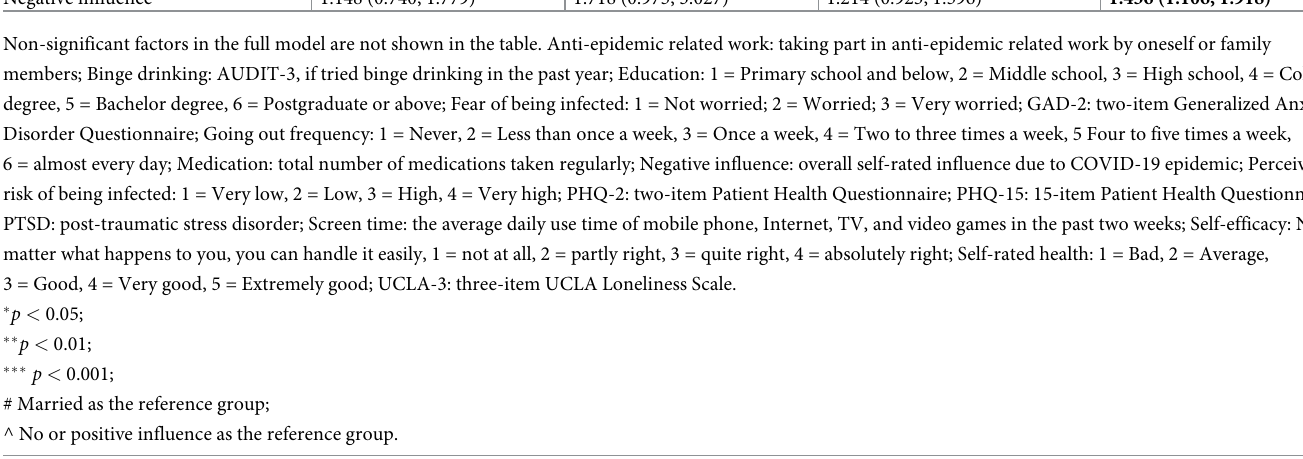
Hubei province, binge drinking, more chronic diseases, more medications taken regularly, higher PHQ-15, lower self-rated health, lower self-efficacy, cases around, higher perceived risk of being infected, longer sedentary time, going out more frequently and farther, longer perceived control time, fear of being infected, and overall negative influence due to COVID-19 ( p < 0.05). In the multivariable regression analysis (Table 3), anxiety was still significantly associated